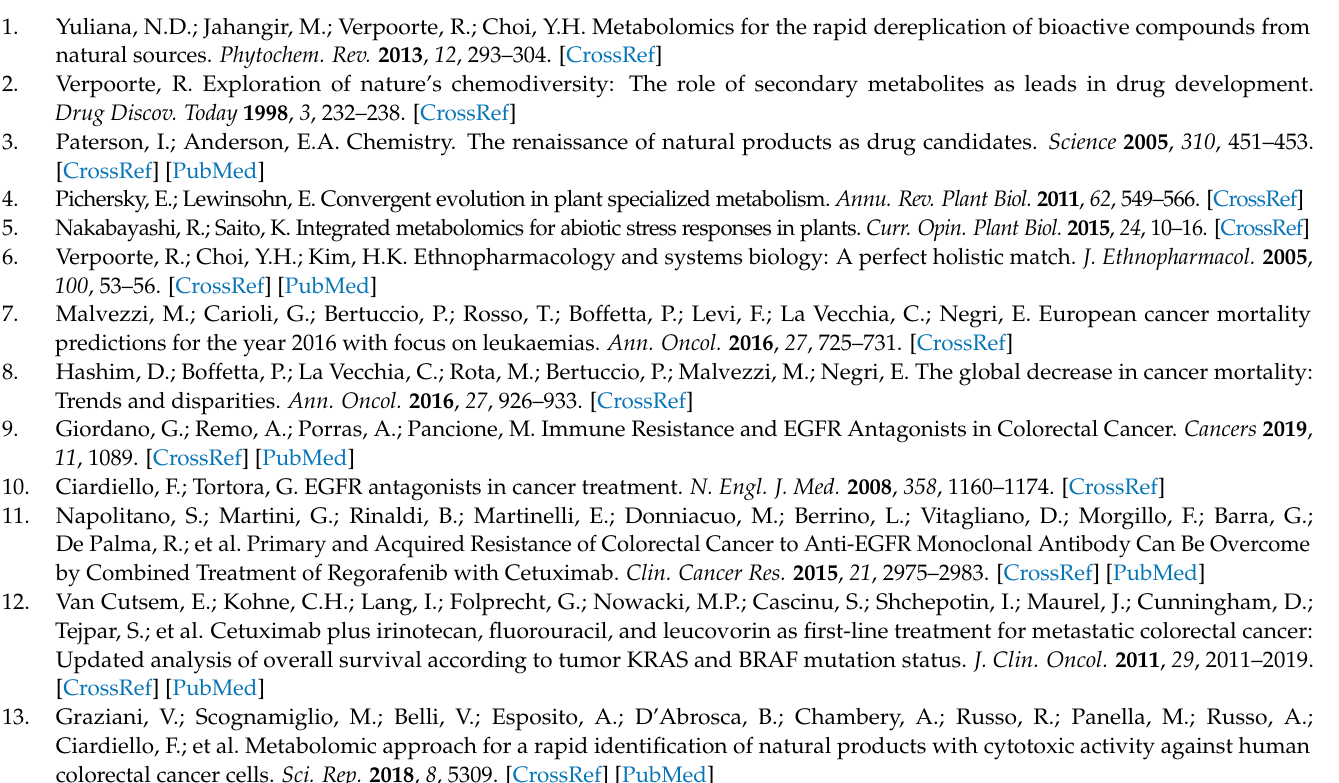
Figure S2: COSY of O. diffusa extract. Figure S3: HMBC of O. diffusa extract. Figure S4: CIGAR-HMBC of OdM fraction. Figure S5: COSY of OdM